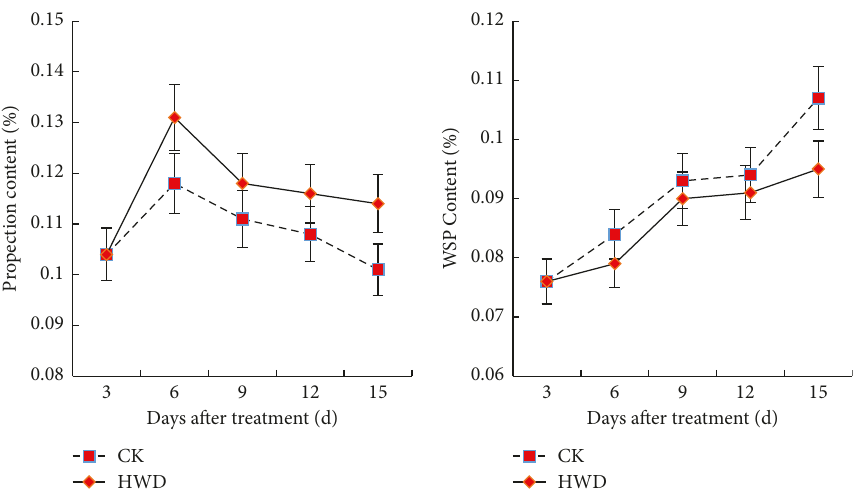
Figure 10: The effect of heat treatment on the content of fruit protopectin, water-soluble pectin, cellulose, and glycoprotein rich in light proline. The vertical line in the figure represents the standard error ( ±